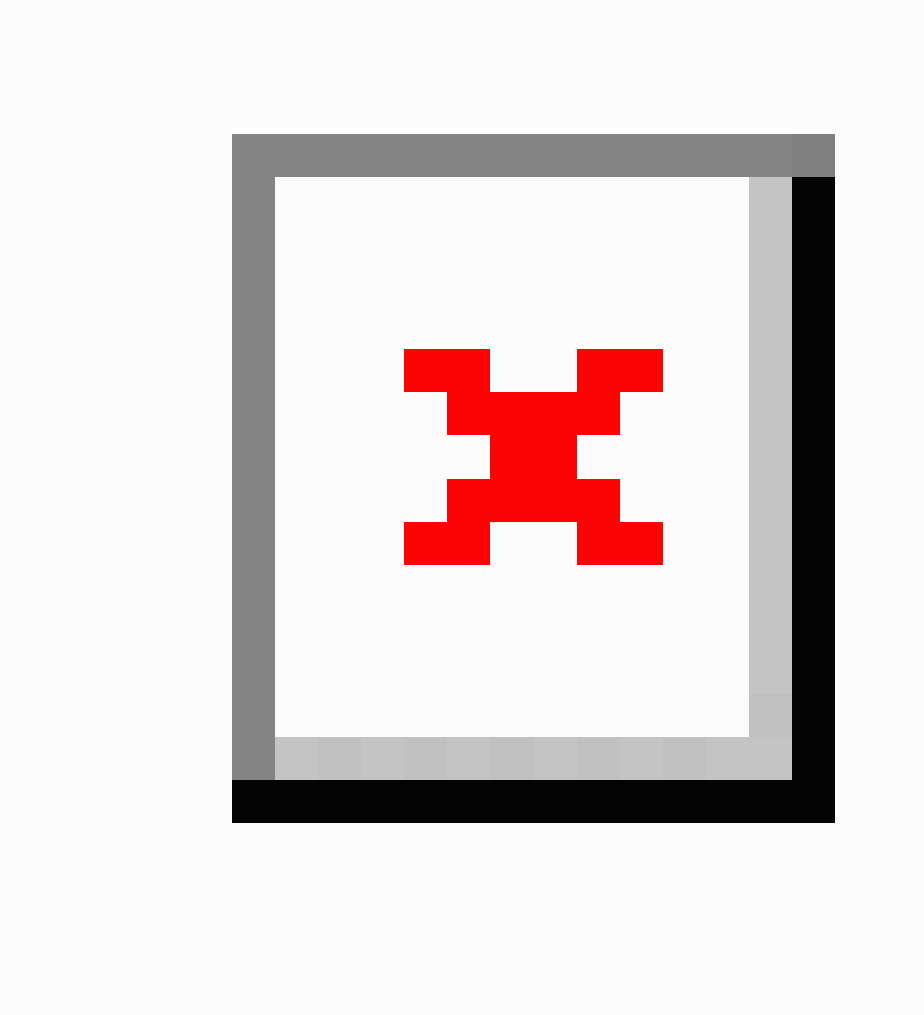
Figure 2. Desired features of mobile fitness